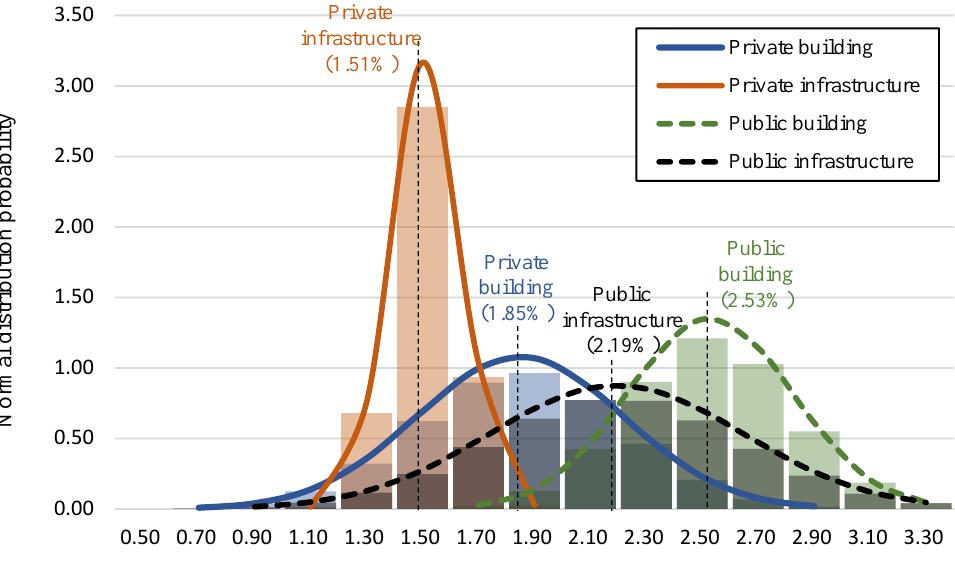
Figure 10. Probability of normal distribution (ratio of APC to TCC) for different facility types.